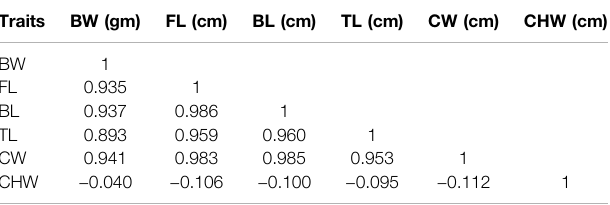
TABLE 1 | Pearson ’ s correlation between growth traits in F1 progeny (n =